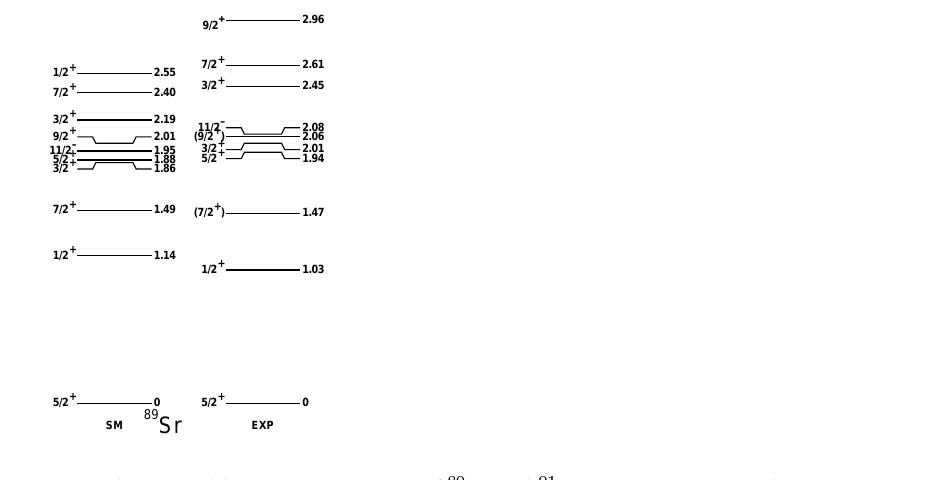
Figure 1. Theoretical low-energy spectra of 89 Sr and 91 Sr in comparison to the experimental data from